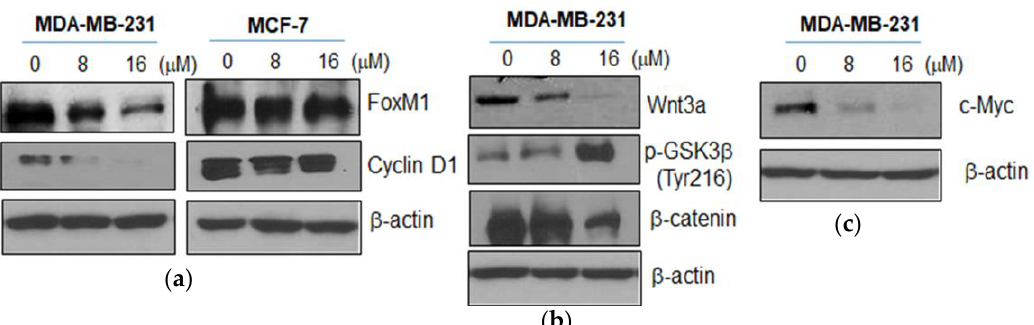
Figure 3. Effect of Moracin D on expression of Forkhead box M1 (FOXM1), Cyclin D1, Wnt3, glycogen synthase kinase 3 beta (GSK3 β ), β -catenin, and c-Myc in MDA-MB-231 cells. MDA-MB-231 and MCF-7 cells were treated with Moracin D (0, 8, or 16 µ M) for 24 h and were subjected to Western blotting with antibodies of FOXM1 and Cyclin D1 ( a ) and also with those of Wnt3, p-GSK3 β , β -catenin, and c-Myc ( b,c ).